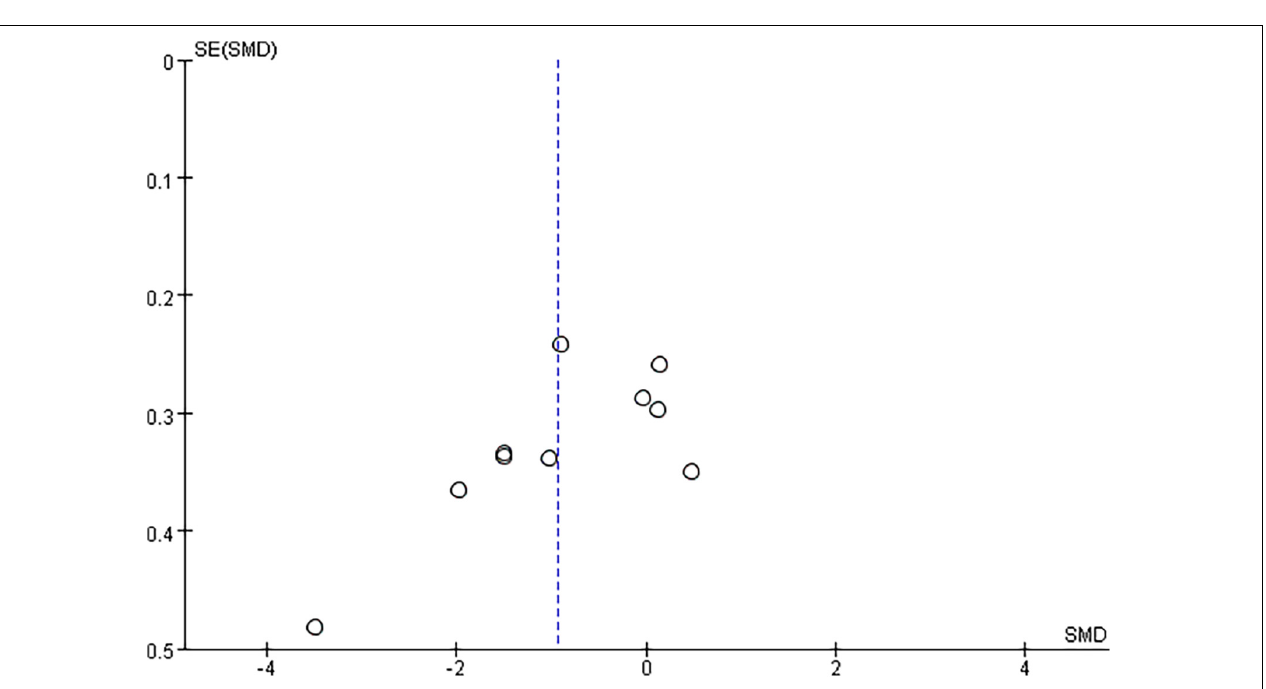
short term, and another study by Allom et al. (2015),